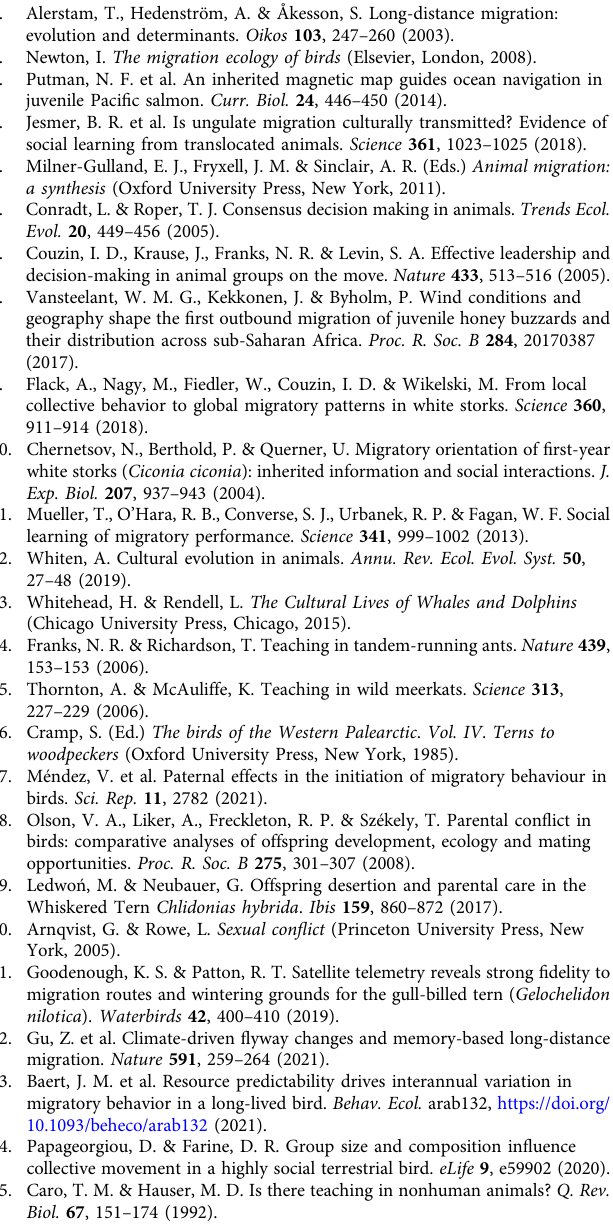
Field protocol . Caspian terns were caught at breeding sites along the Finnish west coast (62°14 ′ N, 21°17 ′ E) and the Swedish east coast (57°16 ′ N, 16°37 ′ E and 65°18 ′ N, 22°23 ′ E). Adults ( n = 13) were caught at the nest during the last week of the incubation phase in late May using spring nets, and juveniles ( n = 18) were caught by hand from the breeding islet just prior to fl edging. Solar-powered GPS-trackers (Ecotone GPS-GSM or OrniTrack GPS-GSM/GPRS trackers) were attached with a leg-loop harness using Te fl on ribbon 39 . Tags weighed 18 – 20g corresponding to c. 3% of tern ’ s body mass at the time of deployment (595± 74g; mean± s.d.). The amount and type of data the devices delivered varied (from 5min to several hours between GPS- fi xes) depending on device model and programming schedule as well as voltage level. Sex was determined from DNA as extracted from blood samples using the salt extraction method 8 .